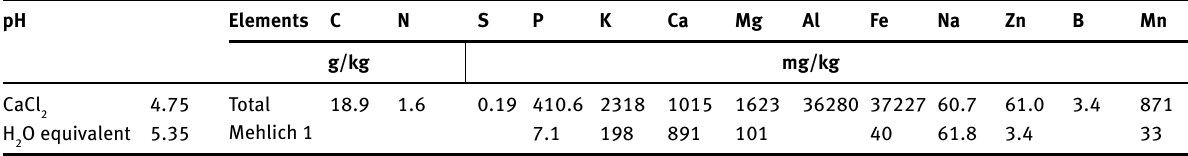
Table 1: Soil characteristics: pH, total and available nutrient content (means, n=3) pH